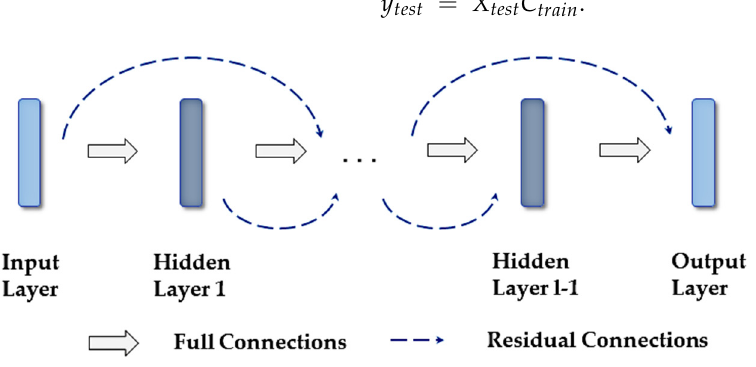
Figure 2. Res-Bp compensation structure.